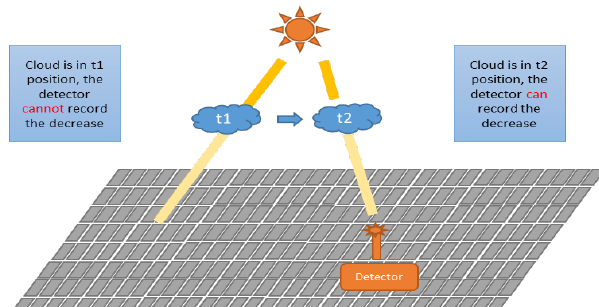
Figure 4. Measuring GHI in different position of the same